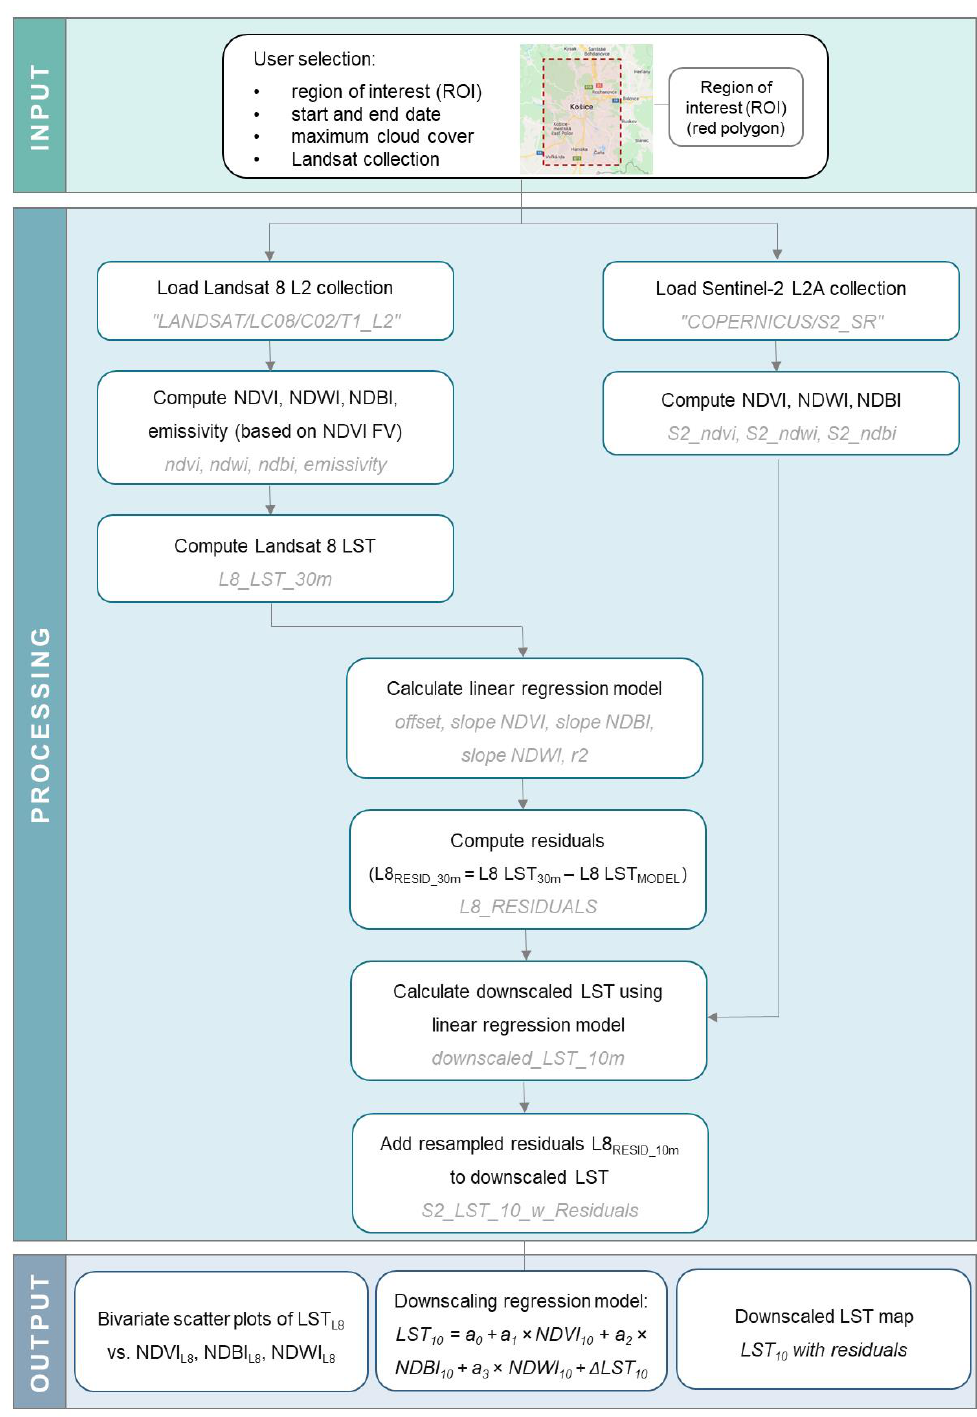
Figure 4. The Google Earth Engine (GEE) processing chain for retrieving downscaled land surface temperature (LST). The black text indicates coded functions in modules. Gray text indicates GEE datasets used in production.